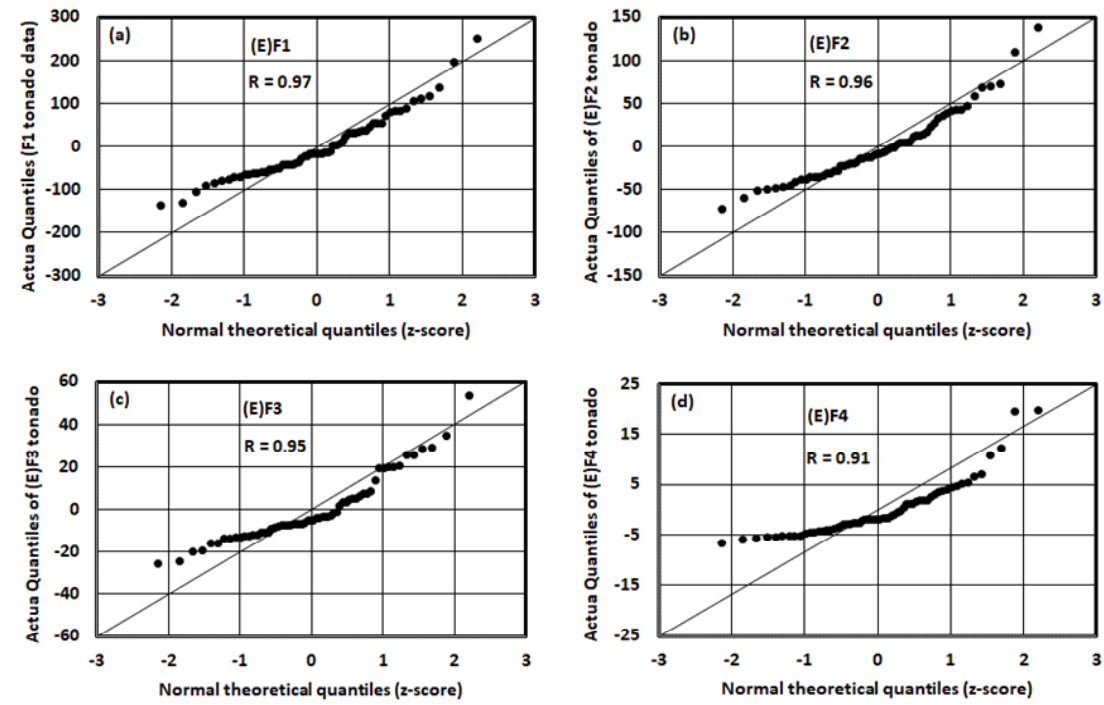
Figure 9. Quantile–Quantile plots for (a) (E)F1, (b) (E)F2, (c) (E)F3, and (d) (E)F4. .